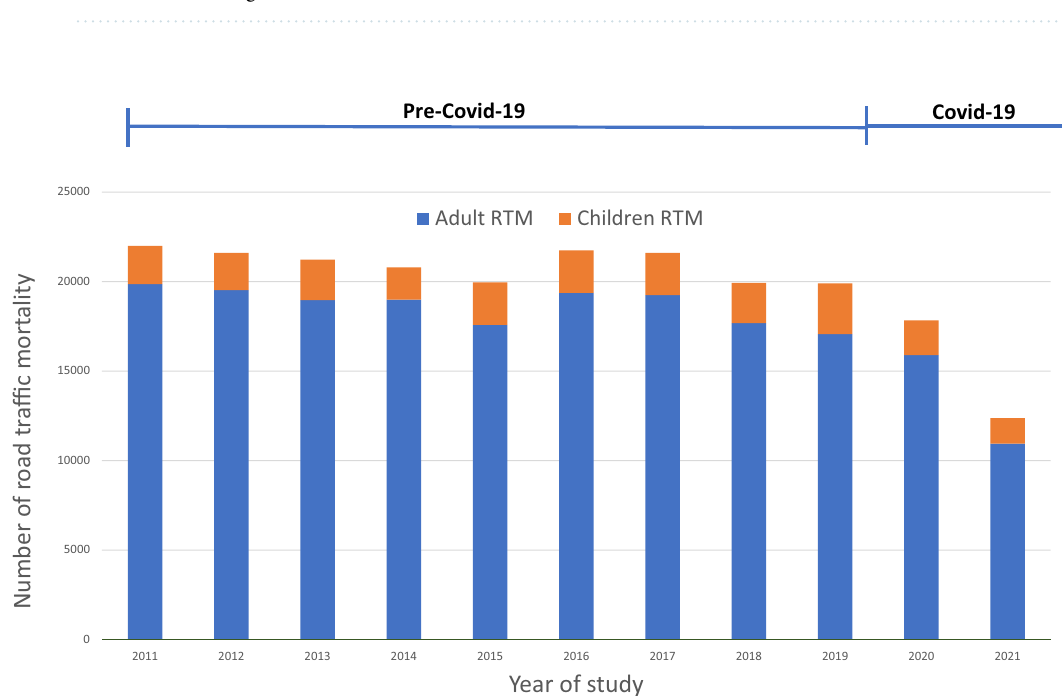
Table 1. Population, sex, mean age, and road traffic mortality (death/100,000 population), divided by adults and children during 2011–2021.